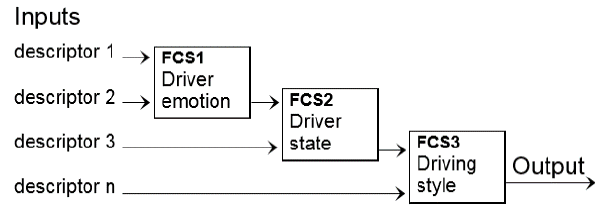
Figure 6. A MFCS model to recognize driving